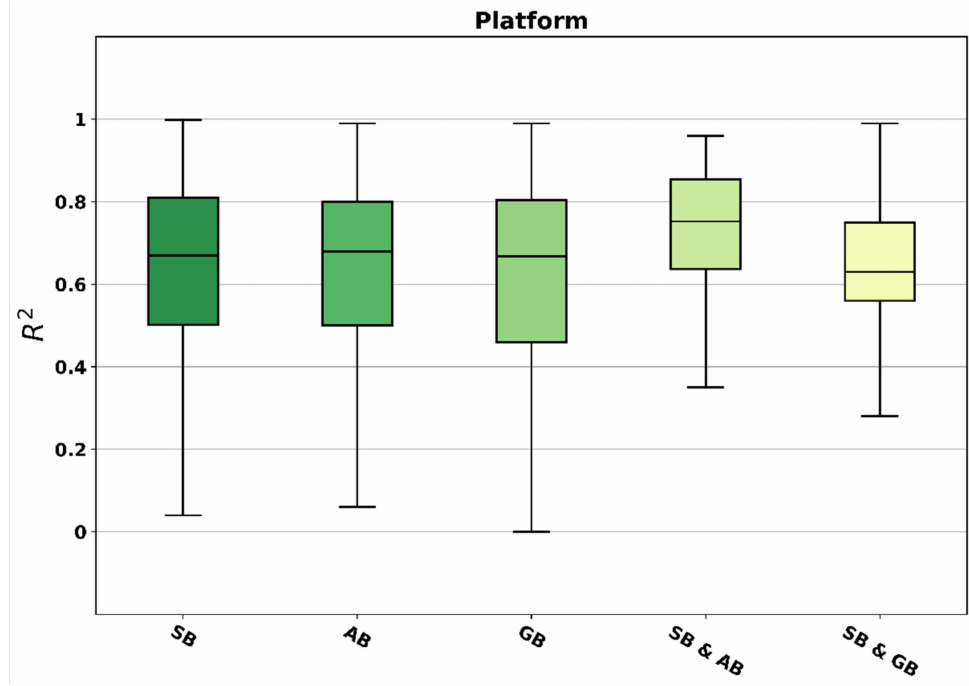
Figure 19. Various platforms’ coefficient of determination (R 2 ) (SB: spaceborne; AB: airborne; GB: ground-based sensors).